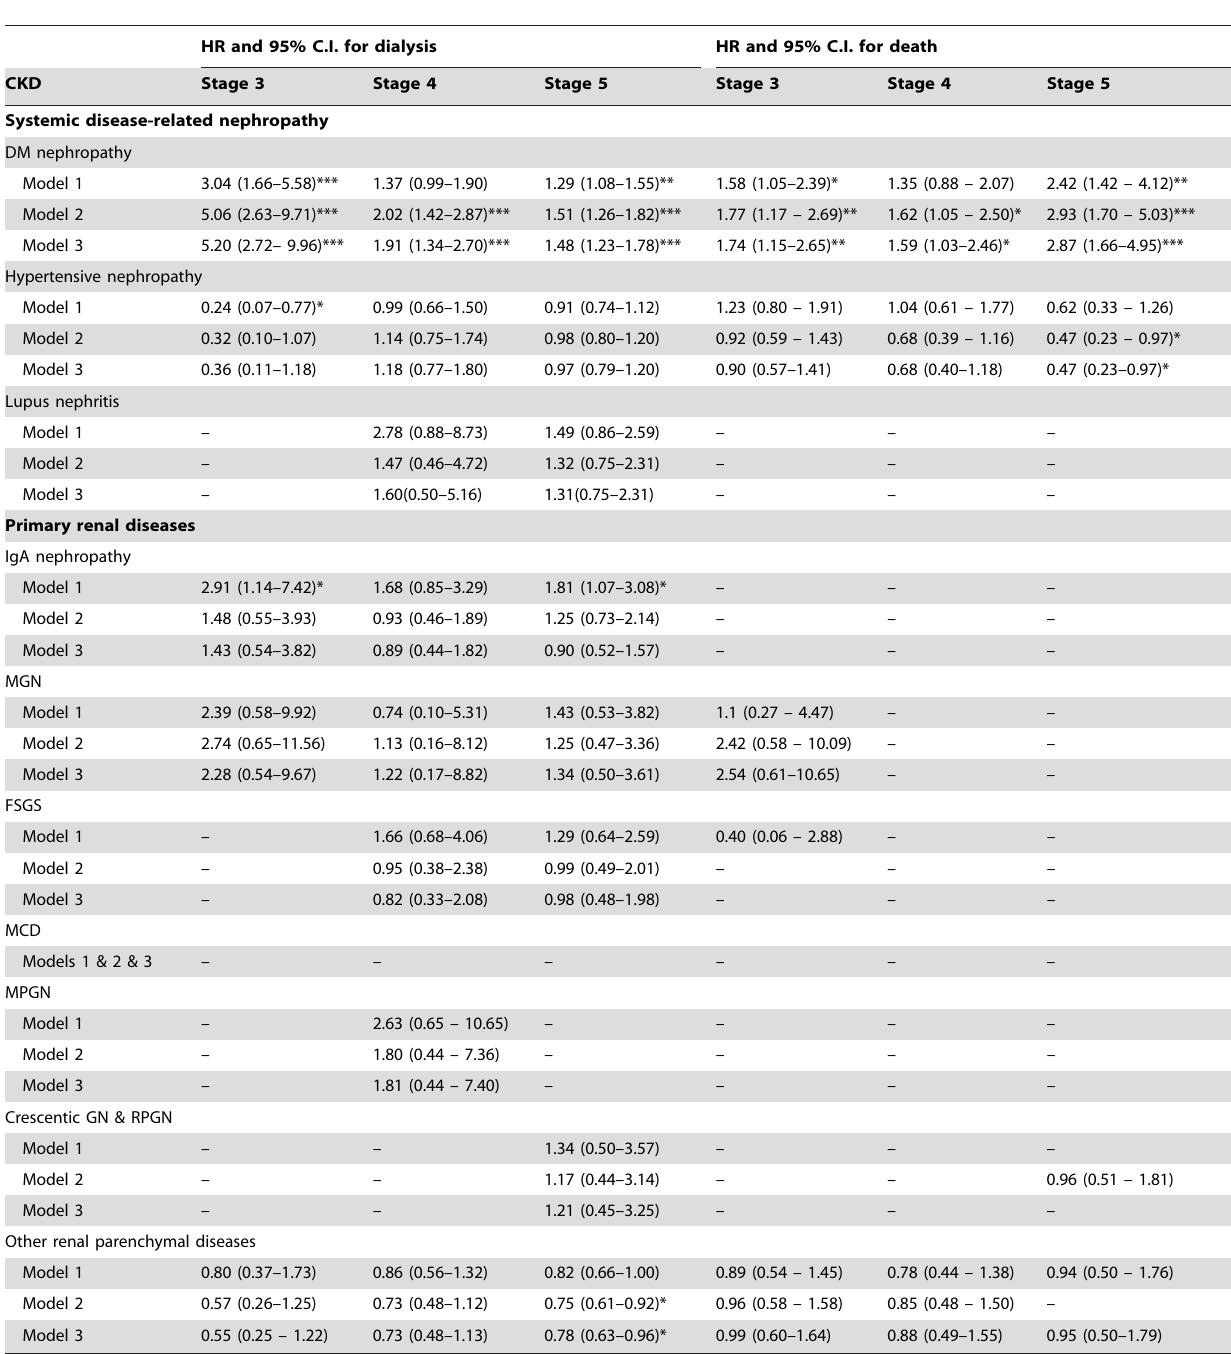
Table 5. Associations of Disease Etiologies eGFR Decline with Dialysis and Death in CKD Stages 3 , 5 Cohort Using Multivariate Cox Proportional Hazards